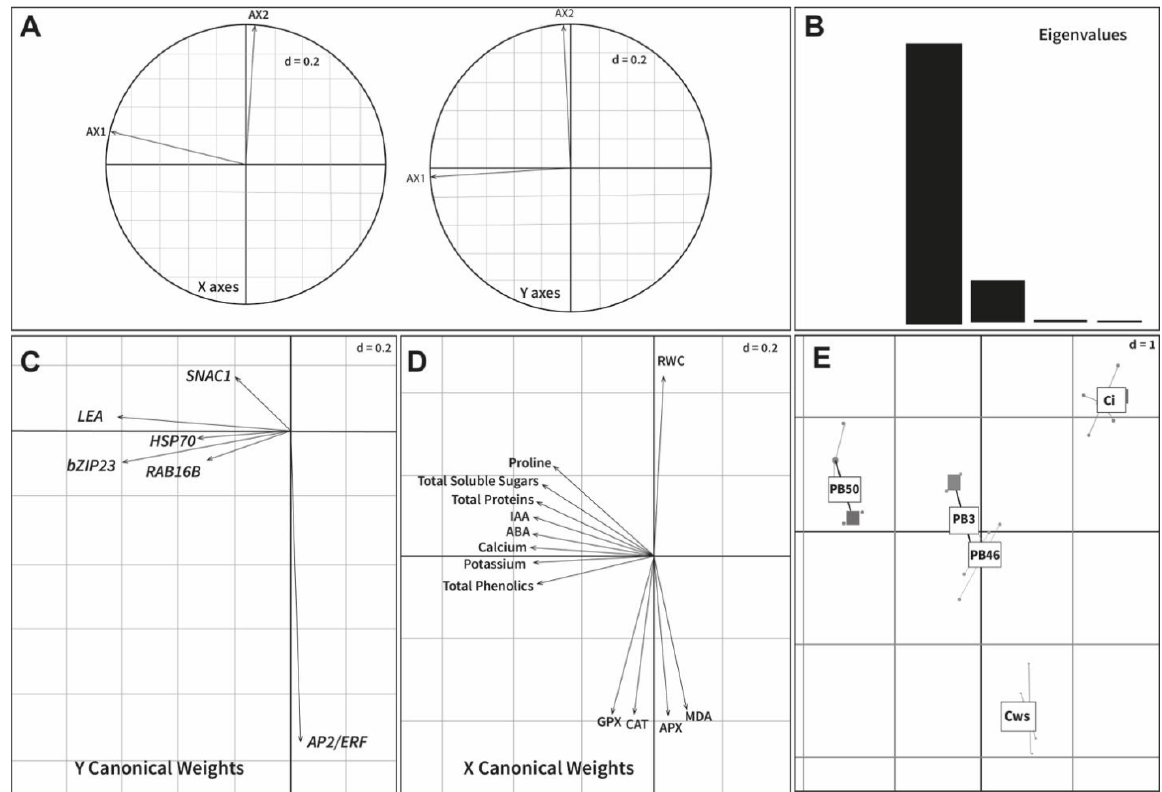
Figure 4. Co-inertia analysis (CIA) results based on two datasets (plant physico- and biochemical variables and gene expression data). ( A ) Projections of the principal axes of the two datasets onto the axes of the co-inertia analysis. X axes: Plant physico- and biochemical variables; Y axes: Drought-responsive gene expression data. ( B ) Scree plot of eigenvalues. ( C ) Correlation of gene expression data with the first two axes of the co-inertia analysis. ( D ) Correlation of plant physico- and biochemical variables with the first two axes of the co-inertia analysis. ( E ) Plot of the first two components in the sample space. Each sample is represented by a square, where the two datasets for each sample are connected by lines to a center point (global